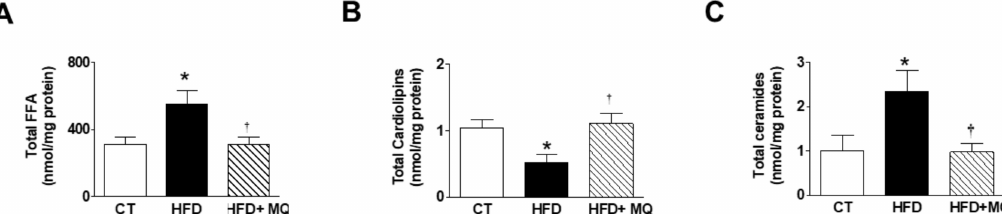
Figure 4. E ff ects the mitochondrial antioxidant MitoQ (MQ) on mitochondrial lipid species in the hearts from obese rats. Hearts from rats fed a standard diet (CT) or a high fat diet (HFD) treated with vehicle or with MQ (200 µ M) were analyzed. Levels of ( A ) mitochondrial free fatty acids (FFA), ( B ) cardiolipins, and ( C ) mitochondrial ceramides are presented. Bar graphs represent the mean ± SEM of 6–8 animals * p < 0.05 vs. control group. † p < 0.05 vs. HFD